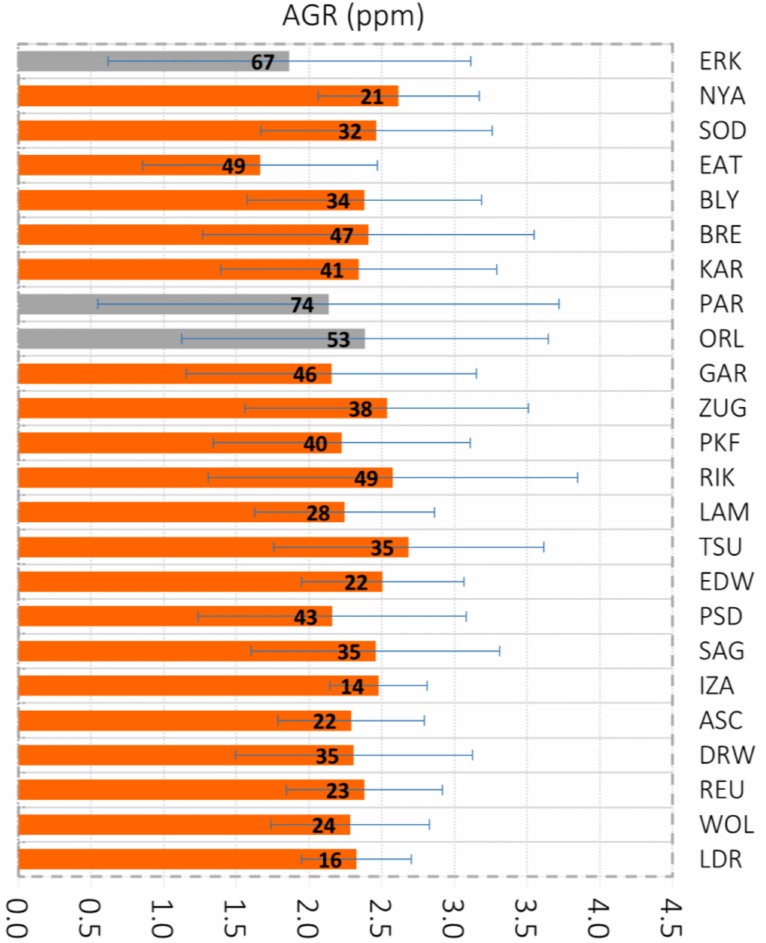
Figure 3. Average AGR TCCON estimates for each TCCON station for 2004–2019 years (horizontal bars). Numbers inside the bars illustrate the relative error bar-related error in % ( σ AGR * Orange bars denote the stations with <50% error, and gray bars denote those with >50% error. The stations are sorted from top to bottom of the plot using the station